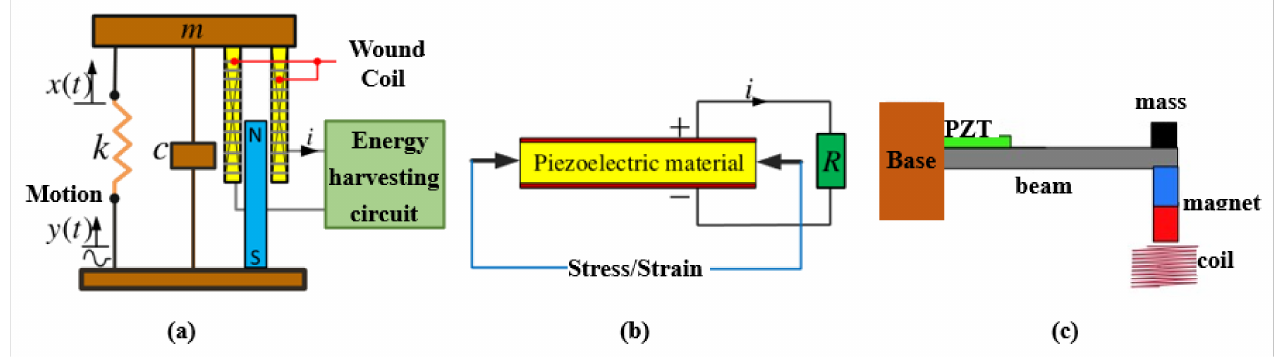
Figure 11. Classification of QZS-based SVIEH [83]: ( a ) Electromagnetic, ( b ) Piezoelectric and ( c )